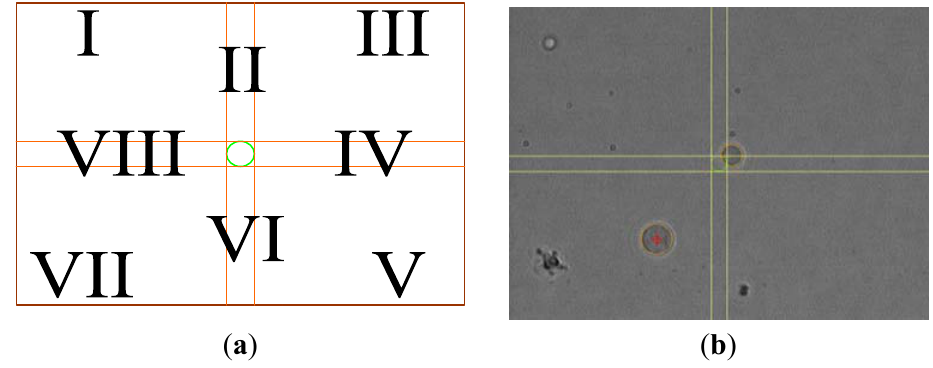
Figure 9. ( a ) The demarcated diagram of electric field direction ( b ) Real view on the PC screen; target radius ratio: